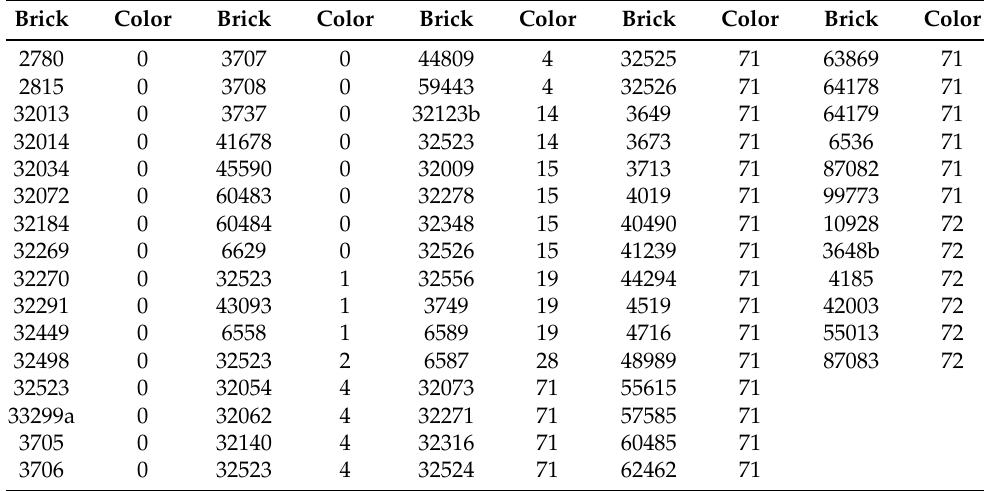
Table 1. Set of 76 different bricks used in this work (bricks and colors are identified by their Lego